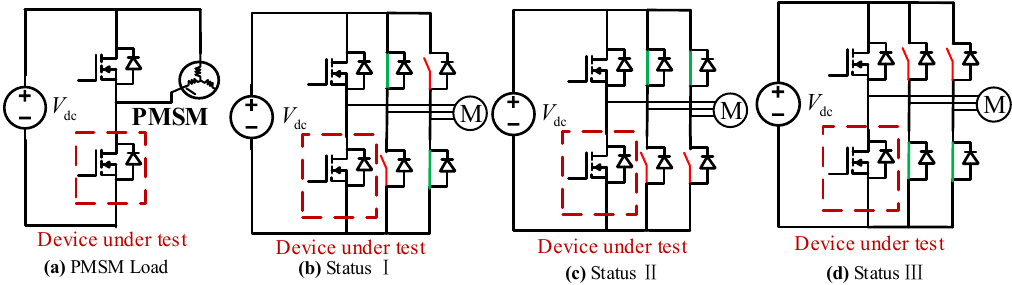
Figure 2. Double Pulse Test of SiC Three ‐ phase Full Bridge.